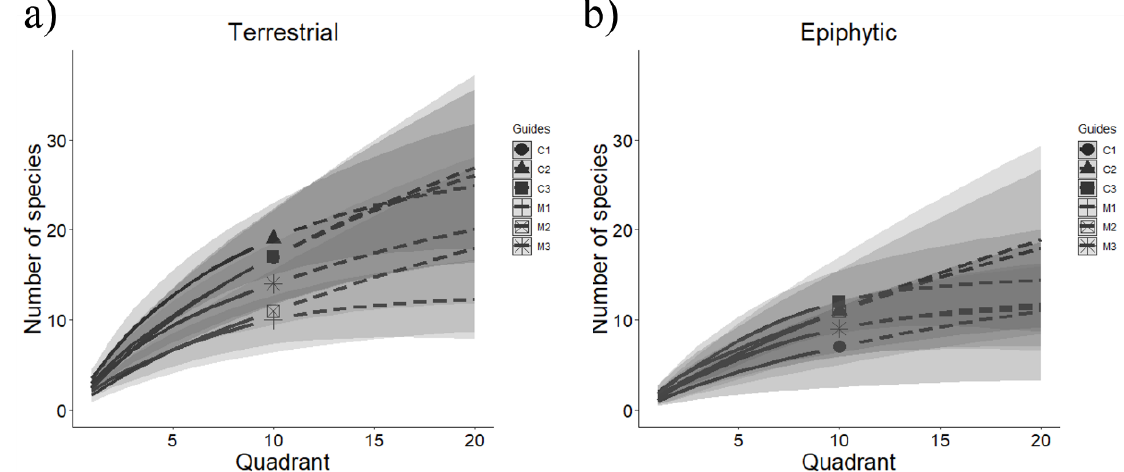
Figure 2. Rarefaction curves (R/E curves) with intrapolation (solid line)/extrapolation (dotted line) of the species richness of ( a ) terrestrial and ( b ) epiphytic mosses among the study sites (Guides). Each curve has confidence intervals of 95%. Confidence intervals overlapping indicate no significant differences in the species richness observed and estimated between managed and conservation sites. Table 2. Beta diversity of terrestrial and epiphytic mosses between conserved and managed forests. Species replacement (βrepl), differences in richness (βrich), and total beta diversity (βTot) are expressed in percentage.